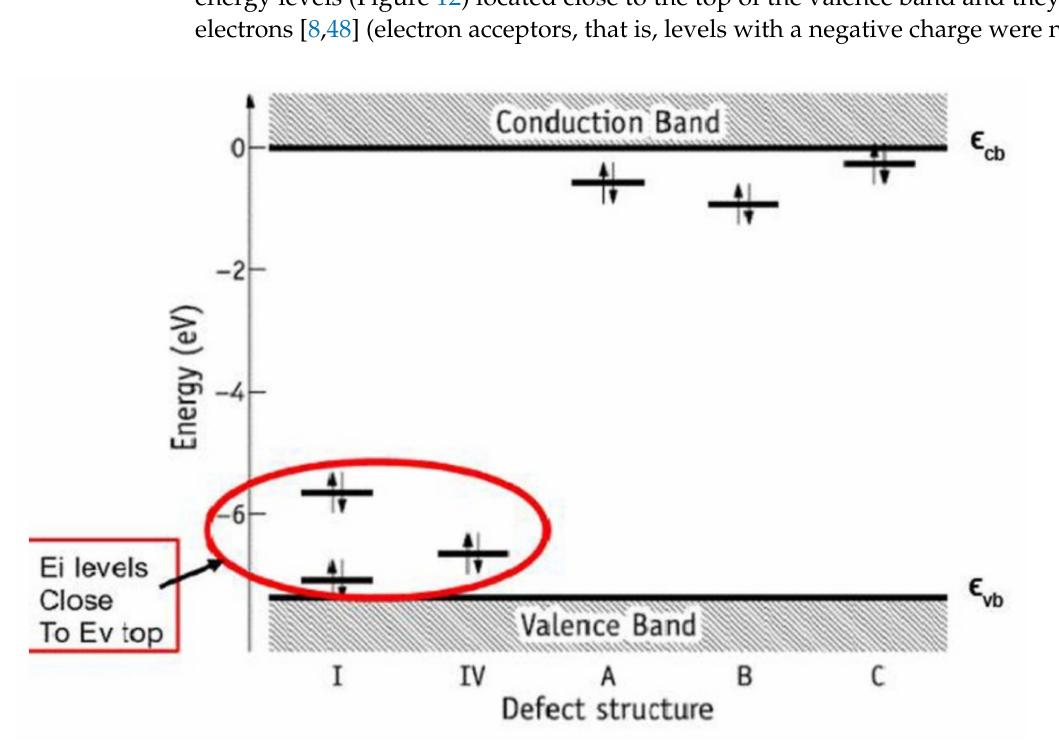
Figure 12. Kohn − Sham energy levels of neutral V O defects in a HAP supercell at the k = Γ point. The defect structure I is also representative of structures II and III (see text). The latter have gap states that deviate from those of V O(I) by less than 0.2 eV [33]. Adapted with permission from [8]. (Copyright (2019) American Chemical